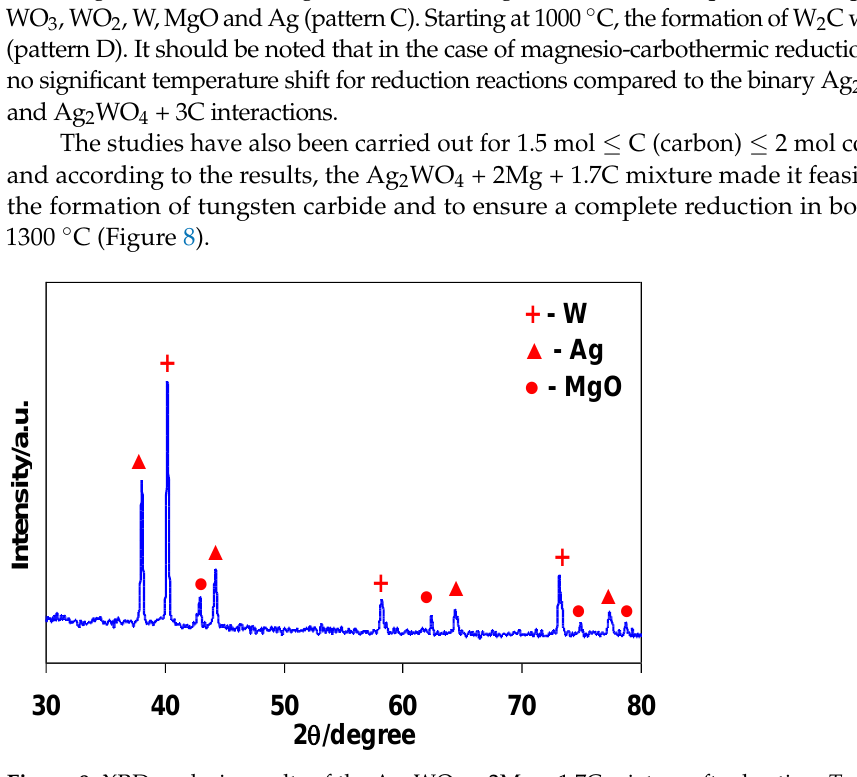
Figure 8. XRD analysis results of the Ag 2 WO 4 + 2Mg + 1.7C mixture after heating, T = 1300 °C.